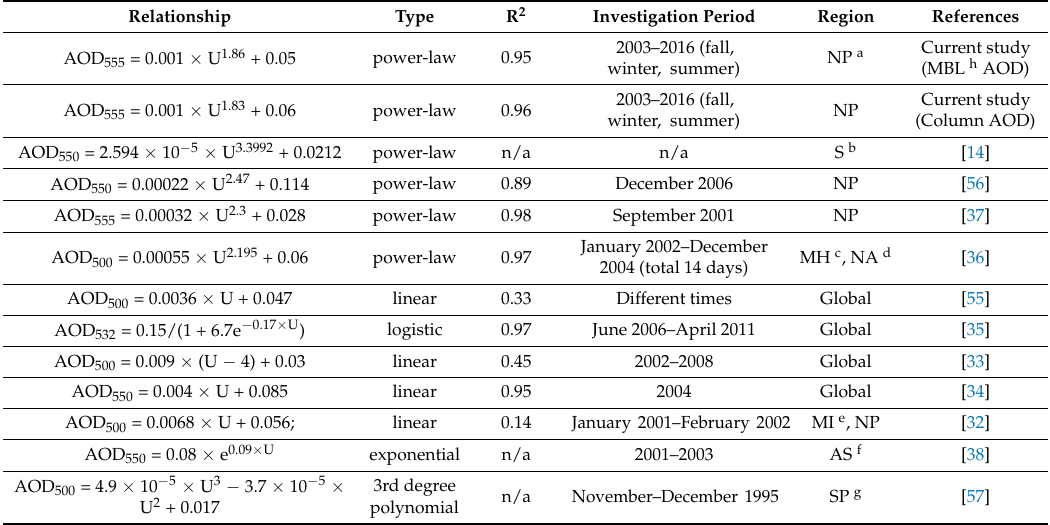
Table 2. Current and previous parametrizations of AOD as a function of surface wind